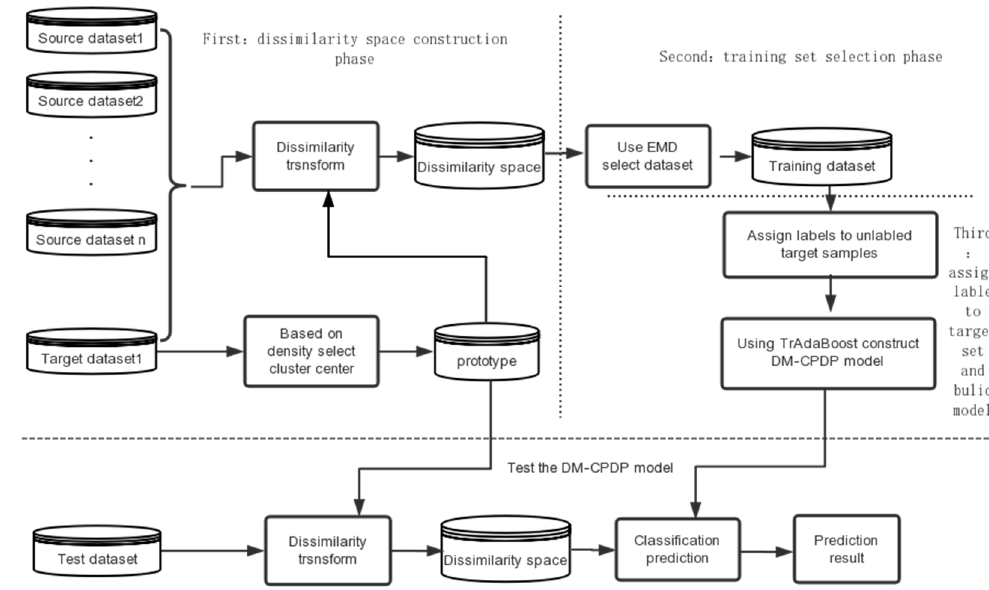
Figure 1. The framework of the multi-source cross-project defect prediction method based on dissimilarity space (DM-CPDP).